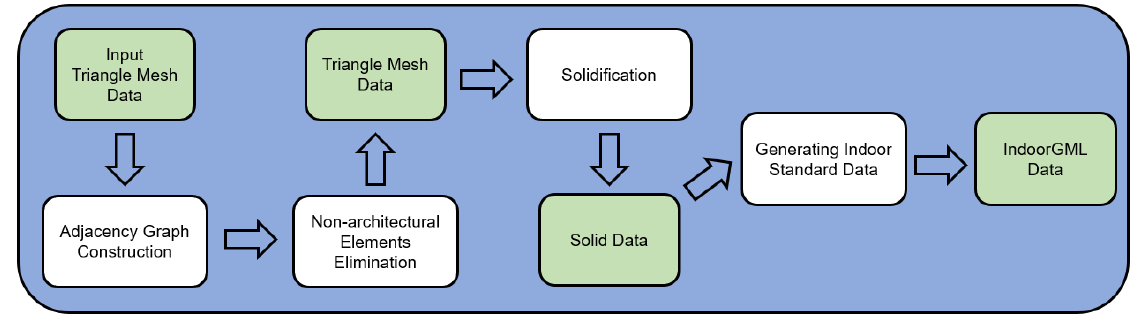
Figure 2. Data change and conversion